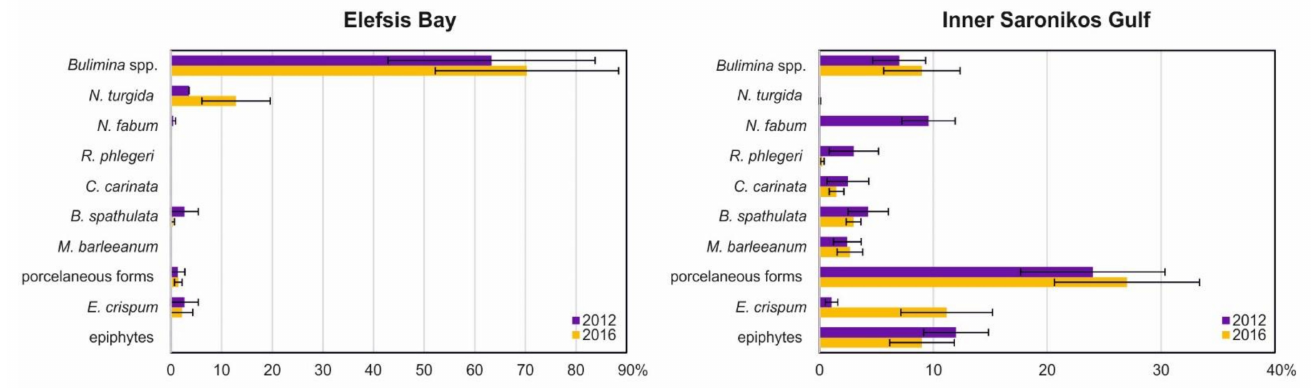
Figure 7. Frequencies of the most abundant foraminiferal taxa (mean and standard error) for 2012 and 2016. Epiphytes include Asterigerinata mamilla , Cibicides lobatulus , and Rosalina bradyi